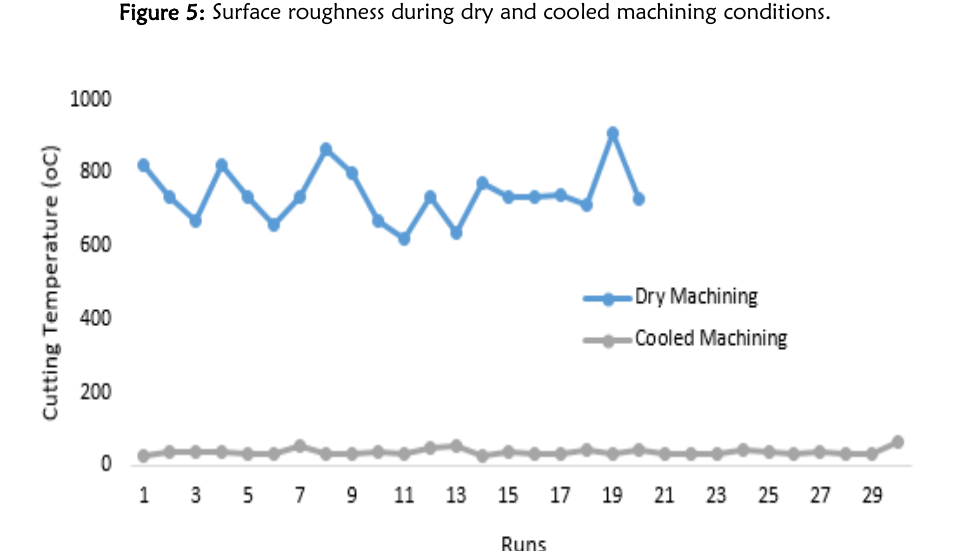
Figure 6: Cutting temperature during dry and cooled machining